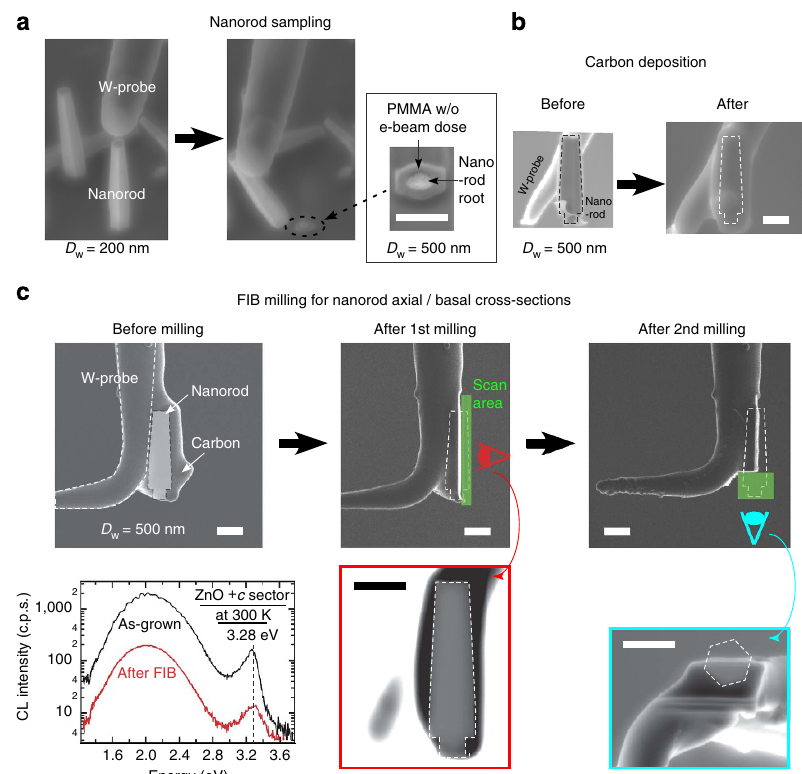
Figure 3 | Nanorod micro-sampling and cross-section fabrication by controlling FIB incidence orientation. ( a ) A nanorod ( D w ¼ 200nm) micro- sampling observed by SEM. The inset SEM image shows the circular nanorod root left after the removal of a nanorod ( D w ¼ 500nm). ( b ) SEM images of a micro-sampled nanorod before and after the amorphous carbon deposition. Nanorod position is indicated by dashed lines. ( c ) A series of FIB milling process observed by scanning ion microscope imaging. Nanorod positions and FIB milling scan areas at each step are indicated by dashed line and half- transparent box, respectively. Axial and basal cross-sections fabricated by first and second FIB milling, respectively, are observed consecutively by SEM. The inset at the bottom left shows Spot-CL spectra of the nanorod þ c top-plane before and after the FIB milling, probed by 4.5keV e-beam. All scale bars indicate lengths of 1 m aqueous solution synthesized ZnO films with Hall mobility of m